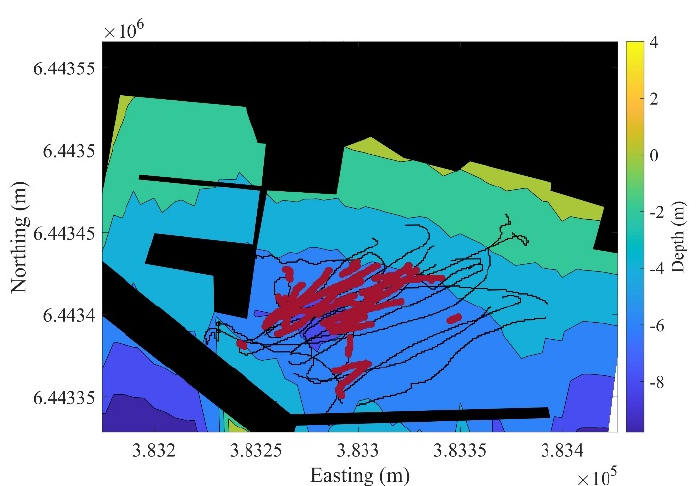
Figure 4. Identified submarine groundwater discharge (SGD) plumes (red circles) from sonar surveys and paths of sonar transects (black lines).